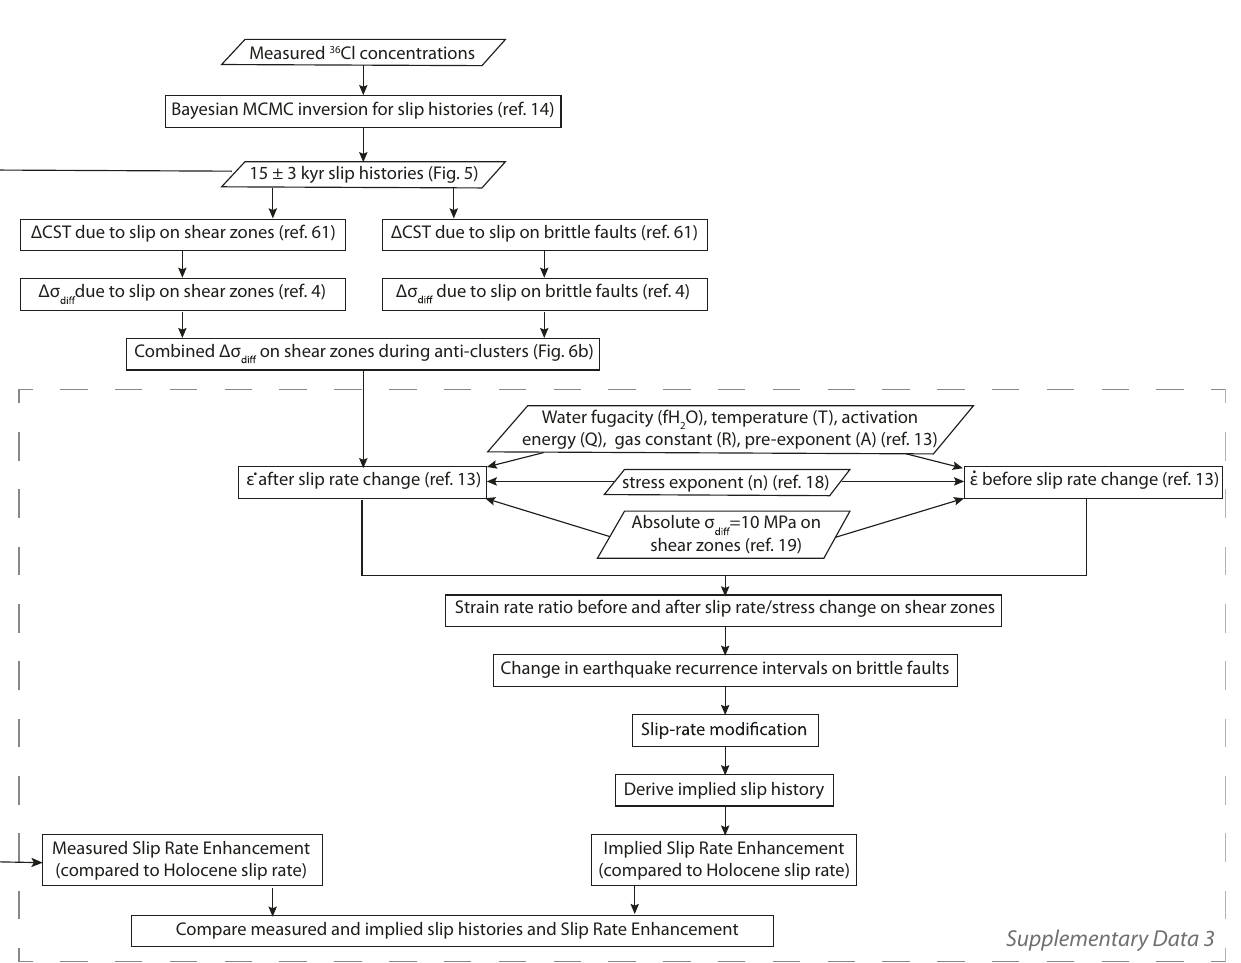
Fig. 3 | Model work fl owto link the surface fi ndings ( 36 Cl-derived slip histories) with modeling stress changes and calculating the resulting changes in strain- rates and slip-rates. Parallelograms represent inputs/outputs and rectangles